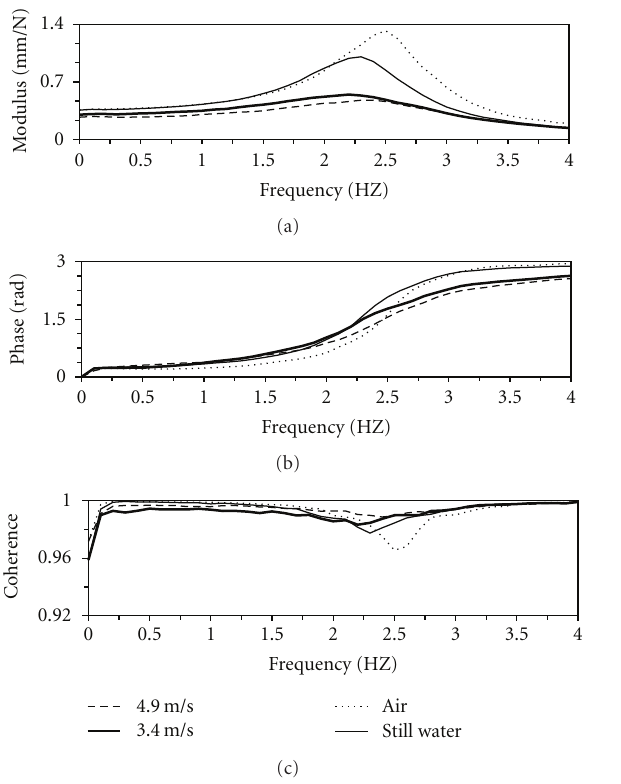
Figure 10: Transfer function H aligned ( ω ); modulus versus frequency (a), phase versus frequency (b); coherence between f aligned and u central versus frequency (c); in still water, and for 3.4 m/s and 4.9m/s fluid